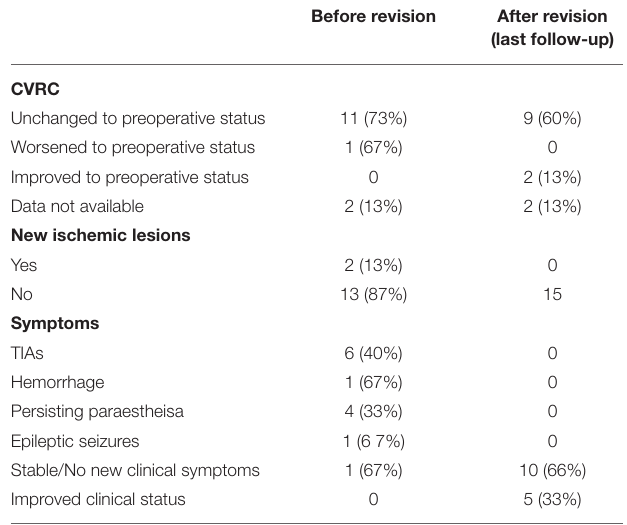
TABLE 3 | Surgical strategies, indication, and timing of repeat revascularization. Second surgical strategy